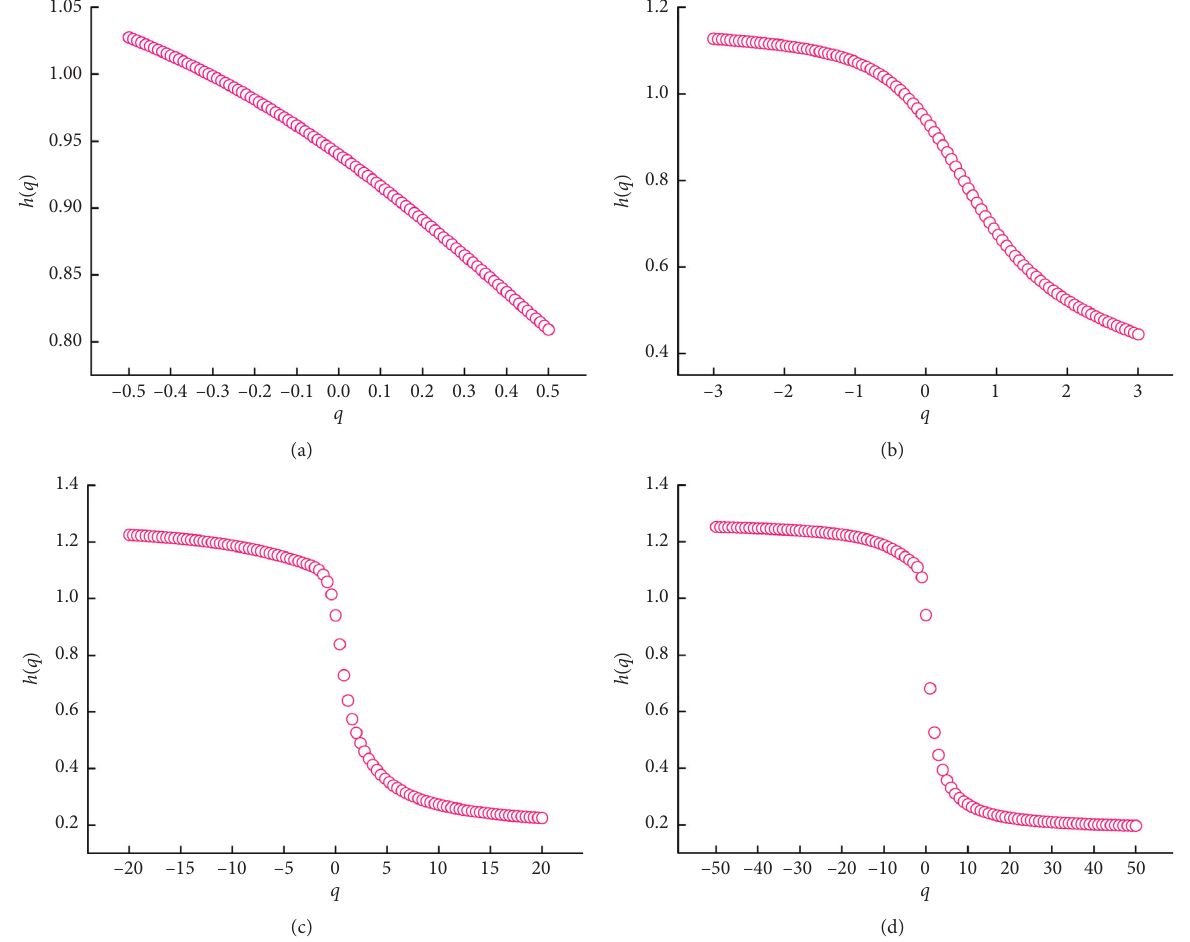
Figure 8: Determining the weight factor q : (a) q ∈ [ − 0.5, 0.5], (b) q ∈ [ − 3, 3], (c) q ∈ [ − 20, 20], and (d) q ∈ [ − 50, 50].